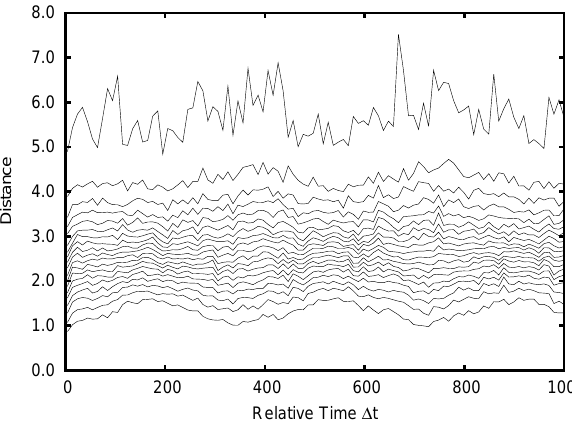
Fig. 4. Space-time separation plot for the detrended time series for τ = 1 and m =